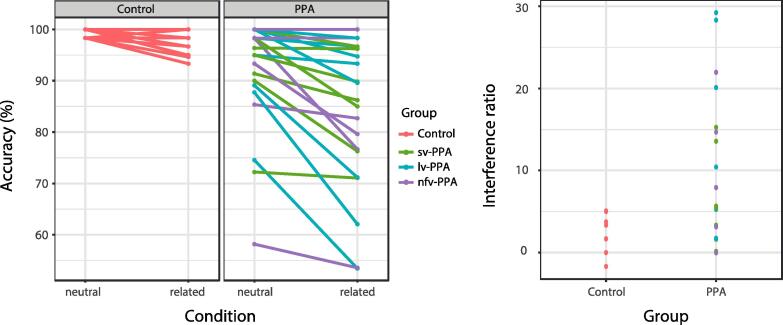
Individual-participant accuracy per noise condition for each group (left) and interference ratio relative to the neutral condition (right). The interference ratio was calculated based on the percentage of correct responses over all valid responses for each noise condition separately. Then, the ratio relative to the neutral condition was calculated as (((accuracy percentage related – accuracy percentage neutral)/accuracy percentage neutral) * −1). The sign of the ratio was inverted for visualization purposes such that positive ratios indicate proportionally more errors in the related than in the neutral condition.